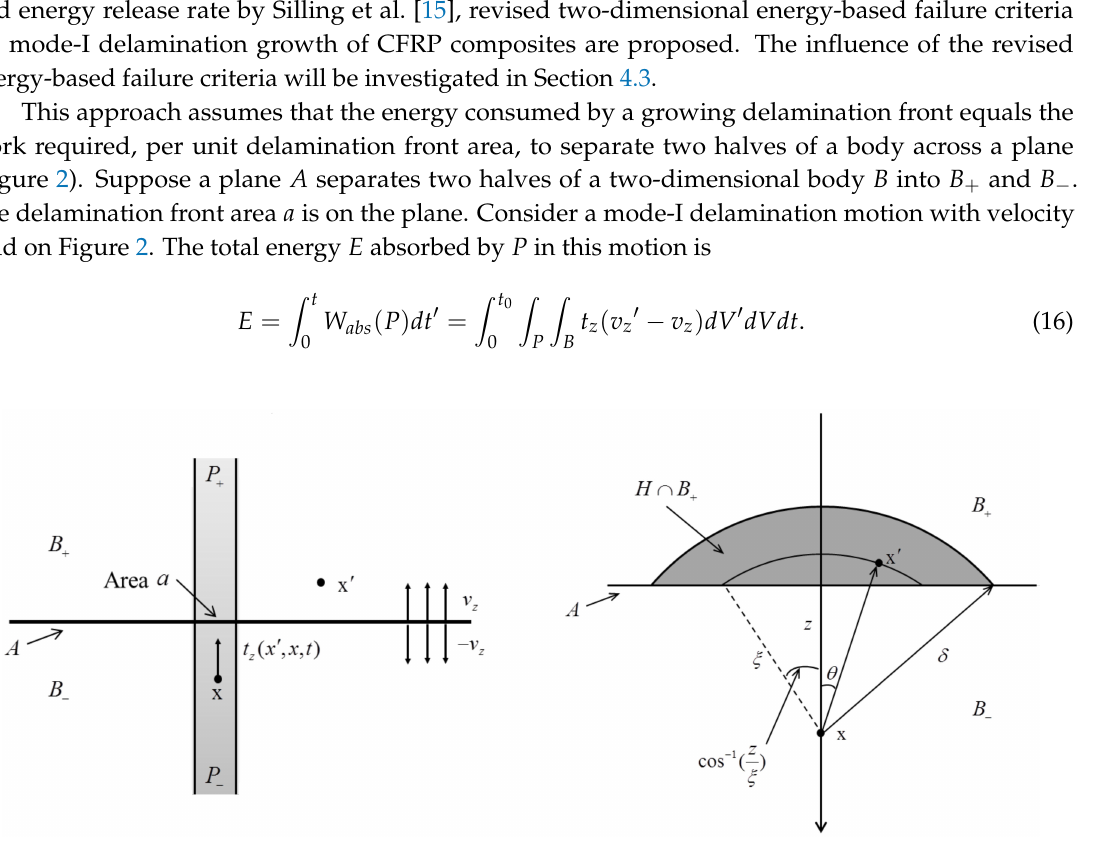
Figure 2. Computation of total energy absorbed by P for delamination front area a